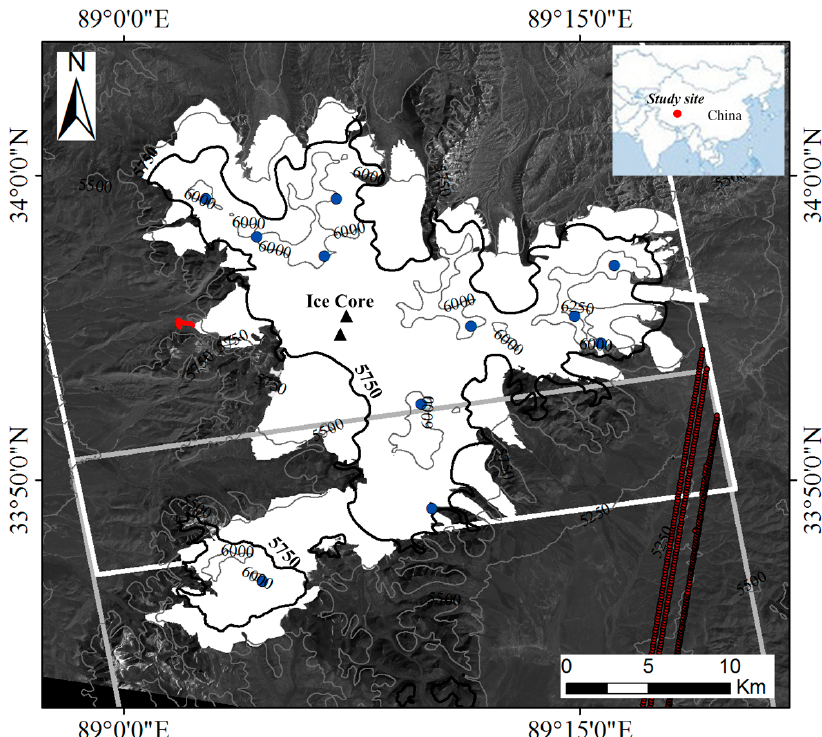
Figure 1. Geographic map of the Puruogangri ice field (white) and its surroundings. The background is the Landsat TM image acquired on 24 September 2007. Contours (m · a.s.l.) are drawn at intervals of 250 m, and the thick line (5750 m) is close to the ELA for the period 2001–2012. The locations of the two ice cores are indicated by black triangles. The coverage of two pairs of TSX/TDX SAR data is shown as grey and white lines. The height GCPs of the 1:50,000 topographic map, ICES at footprints and GPS points are indicated as blue, brown and red dots, respectively.